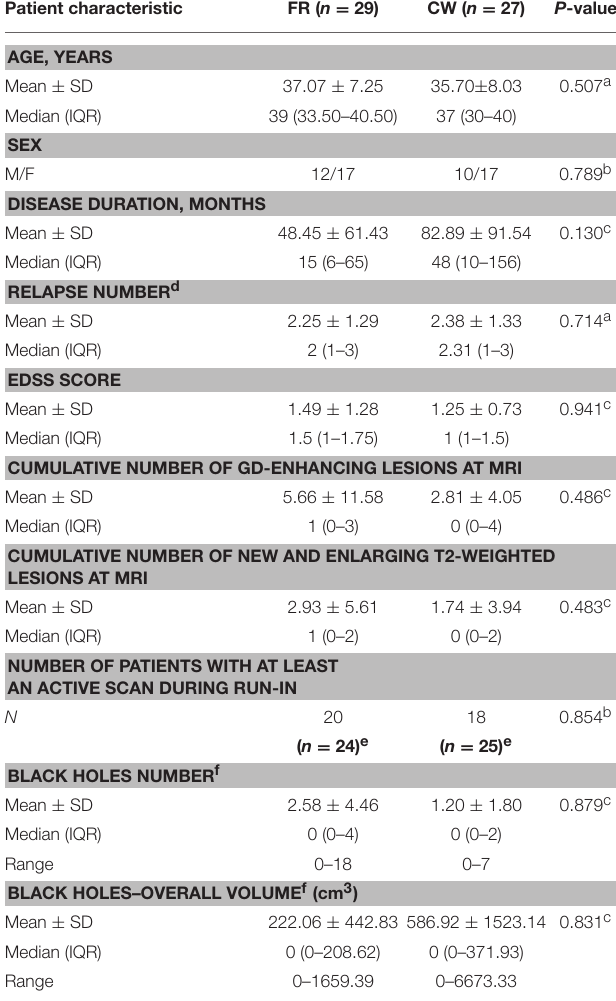
TABLE 1 | Baseline demographic and clinical metrics, along with MRI outcome measures after run-in. Patient